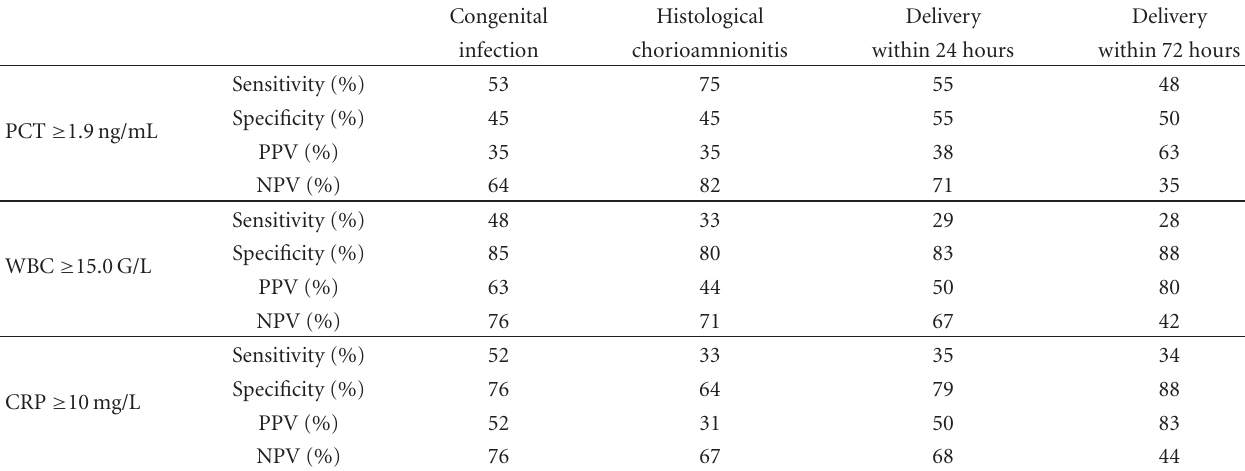
Table 4: The prognostic value of maternal plasma procalcitonin (PCT), white blood cell (WBC) count, and C-reactive protein (CRP) determinations in the prediction of newborn’s congenital infection, histological chorioamnionitis, and pPROM-to-delivery interval. PPV denotes positive predictive value; NPV denotes negative predictive value. Congenital